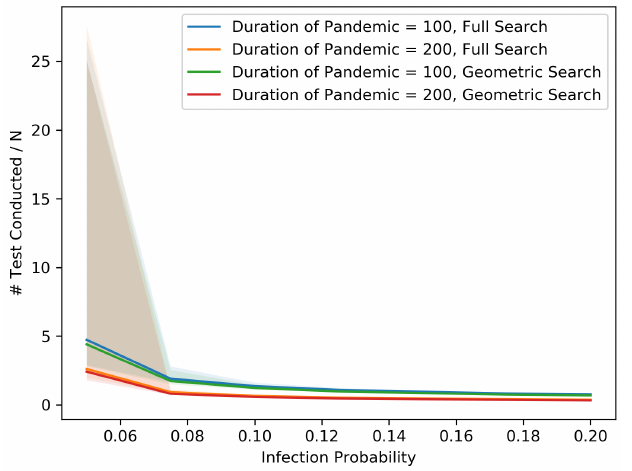
Figure 7. Number of Tests. Population = 250,000 Non-cooperative Rate = 0.333. N: number of people inside and containing the external